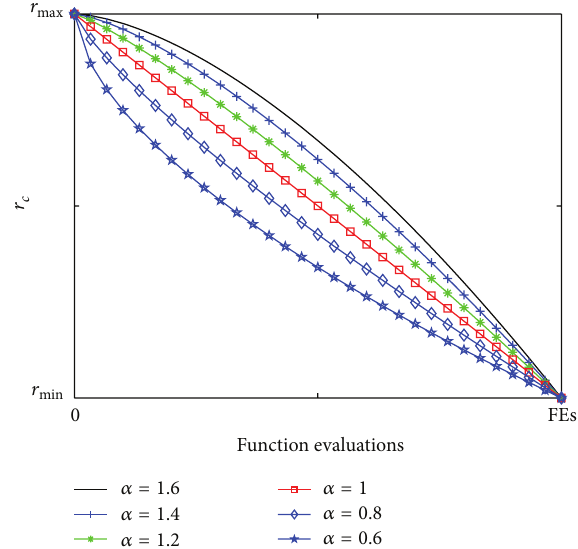
Figure 3: Variations of 𝑟 𝑐 with functions evaluations for different settings of 𝛼